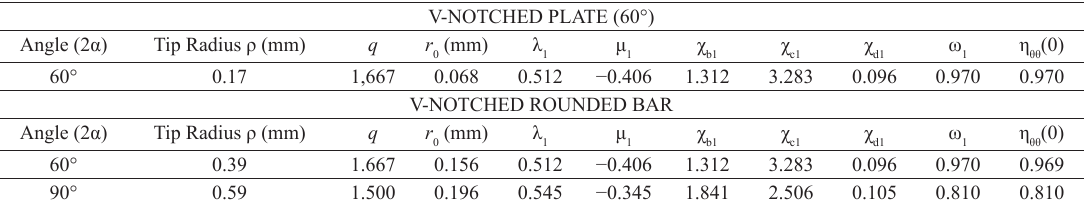
Table 3 presents the parameters necessary to compute the stress intensity factor for V-notched specimens 22 . After machining, the specimens were preheated at 600°C for 15 min and austenitized at 1,150°C for 30 min. Afterward,